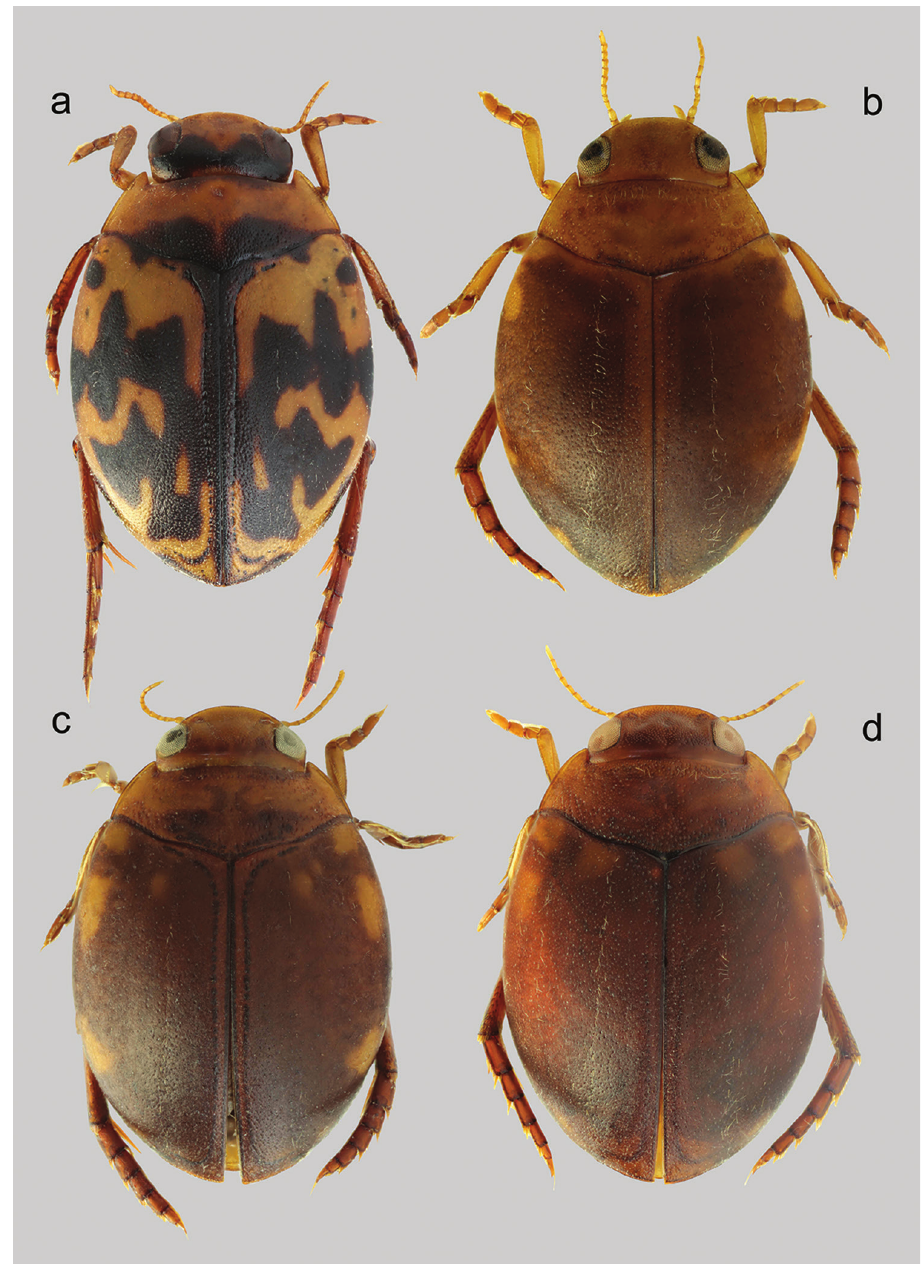
Figure 5. Hyphydrus female habitus. a H. aubei (Croatia; 4.7 mm) b H. ovatus (Bohemia; 4.6 mm) c H. anatolicus (Greece; 5.0 mm) d H. sanctus (Turkey; 4.9